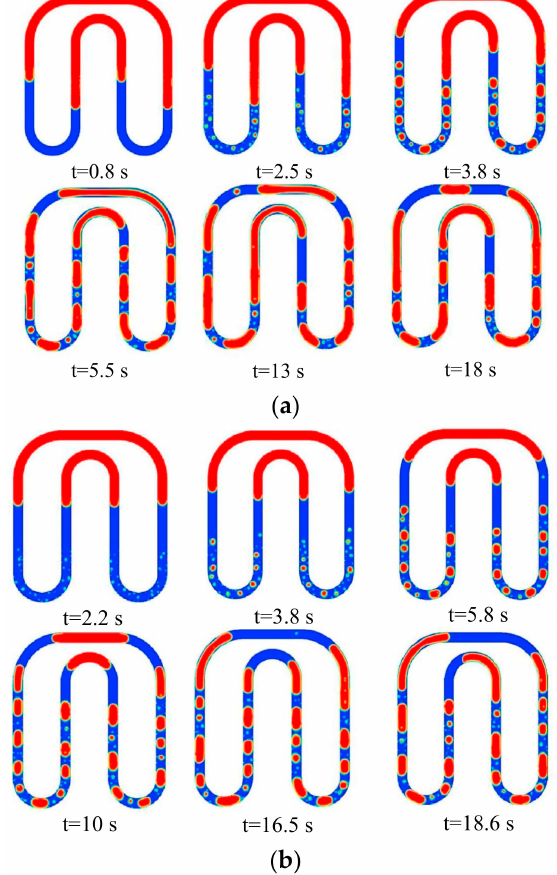
Figure 13. Volume fraction contours after formation of fluid flow [202]. Pouryoussefi et al., (2016). ( a ) Th = 145 ◦ C, Tc = 35 ◦ C, and 30% liquid filling rate; ( b ) Th = 150 ◦ C, Tc = 35 ◦ C and 60% liquid filling